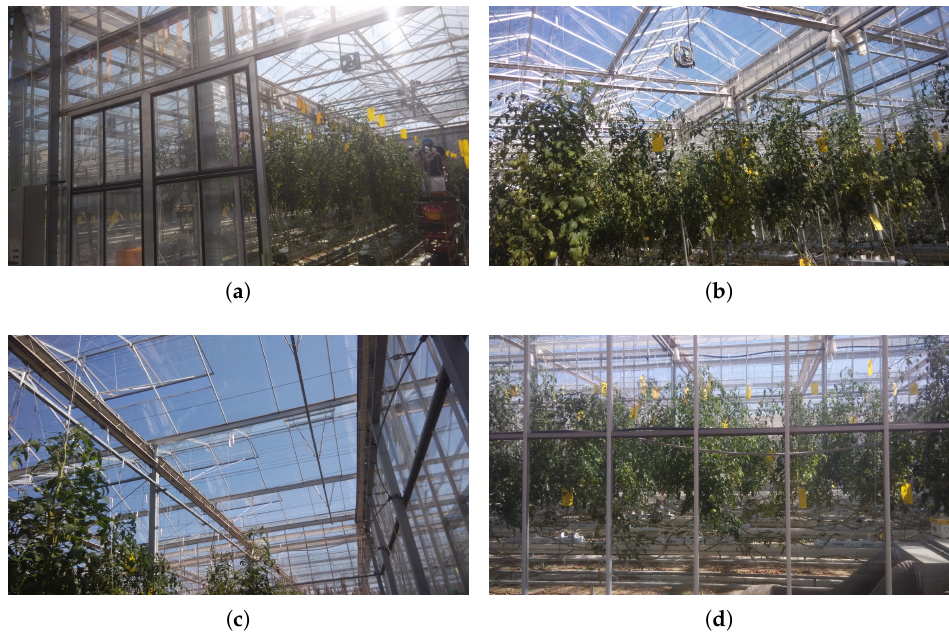
Figure 6. Case study greenhouse with tomato crop. ( a ) A-frame architecture; ( b ) Force fans for ventilation; ( c ) Natural ventilation; ( d ) Heater and evaporative cooling system. Table 3. Characteristics of the